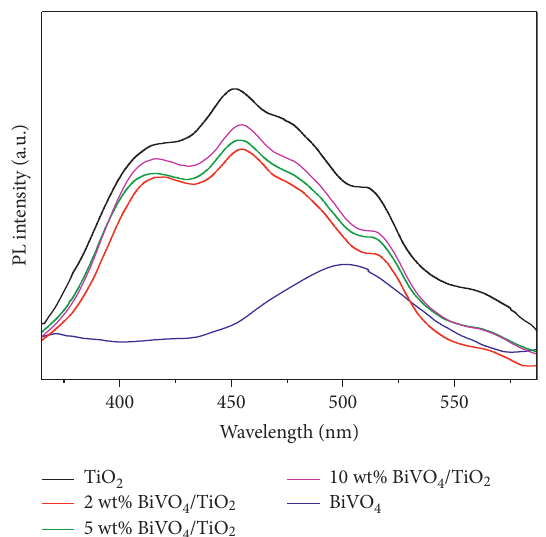
Figure 10: Photoluminescence spectra of